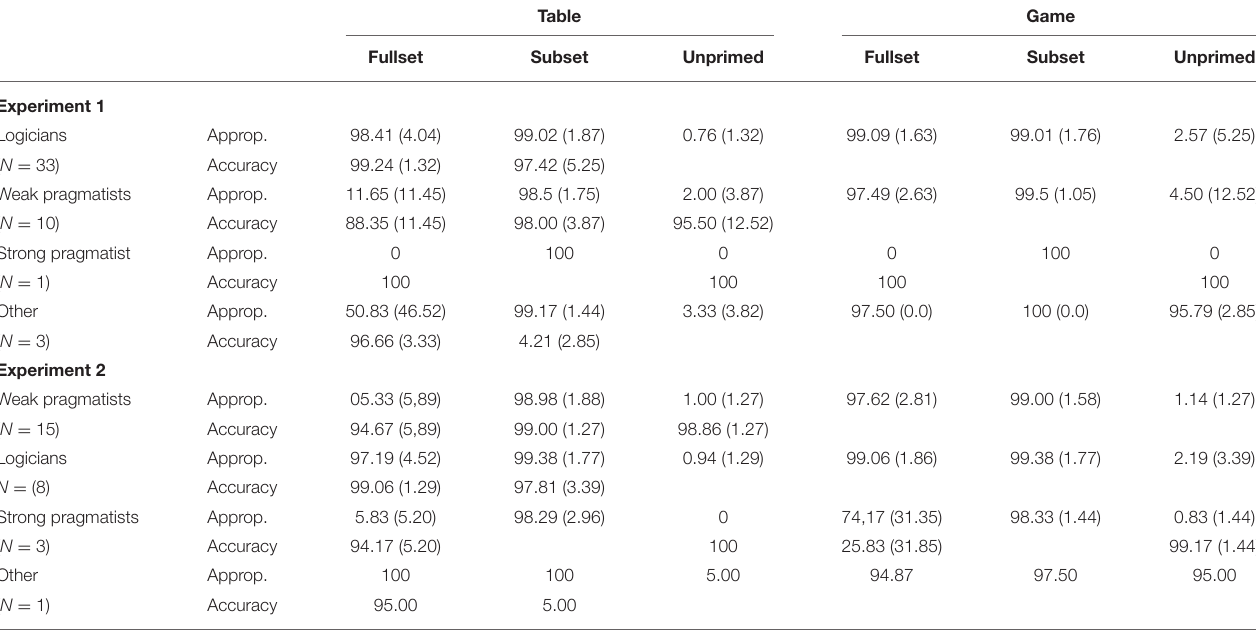
TABLE 2 | The mean percentage (with standard deviation) of trials per condition judged as “appropriate,” after excluding occasional missed trials. Table Game Fullset Subset Unprimed Fullset Subset Unprimed